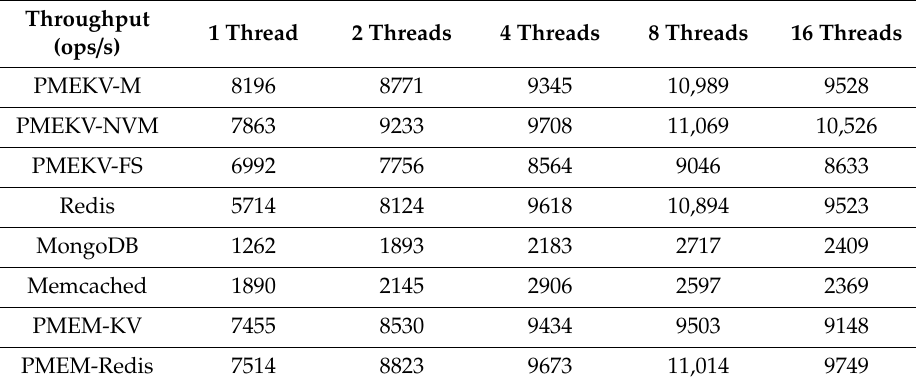
Table 3. The results of changing the number of threads on